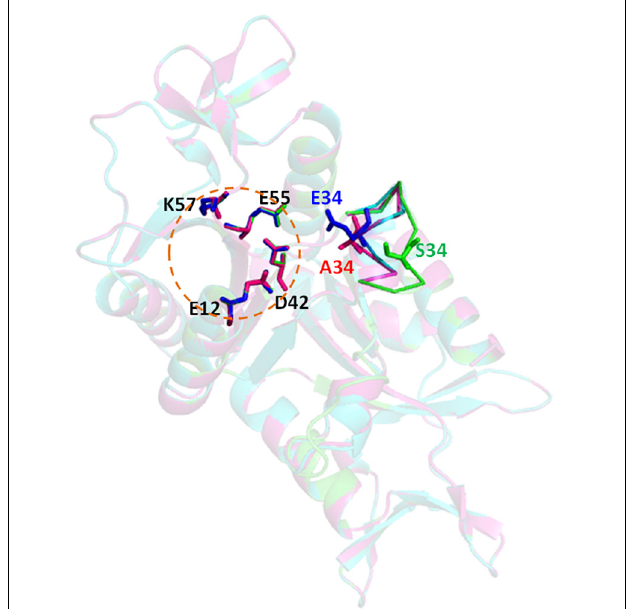
aligned together in which wild type (S34), S34A, and S34E are in blue, pink, and green colors, respectively. The circular dotted line indicates the catalytic center consisting of four highly conserved residues, E12, D42, E55, and K57. A five-amino acid loop containing the mutated residue is shown as sticks. The distances between the 34th amino acid to the closest catalytic residue D42 are D42-S34 ∼ 9.9Å, D42-A34 ∼ 5.4Å, and D42-E34 ∼ 4.7Å,